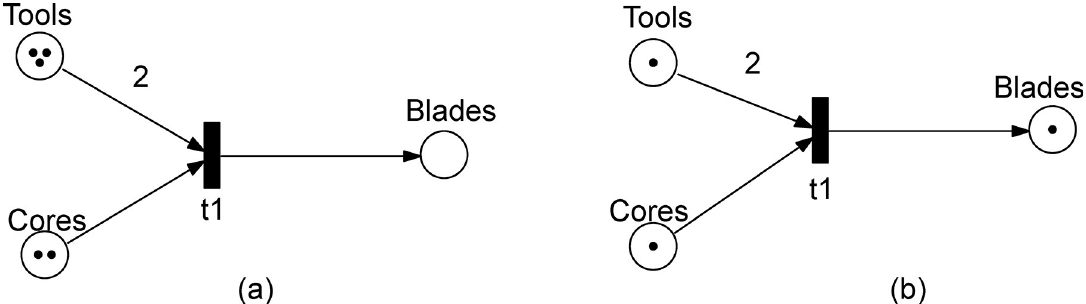
Fig 1. Blade production model to illustrate the graphical representation, markings and firing rule of Petri